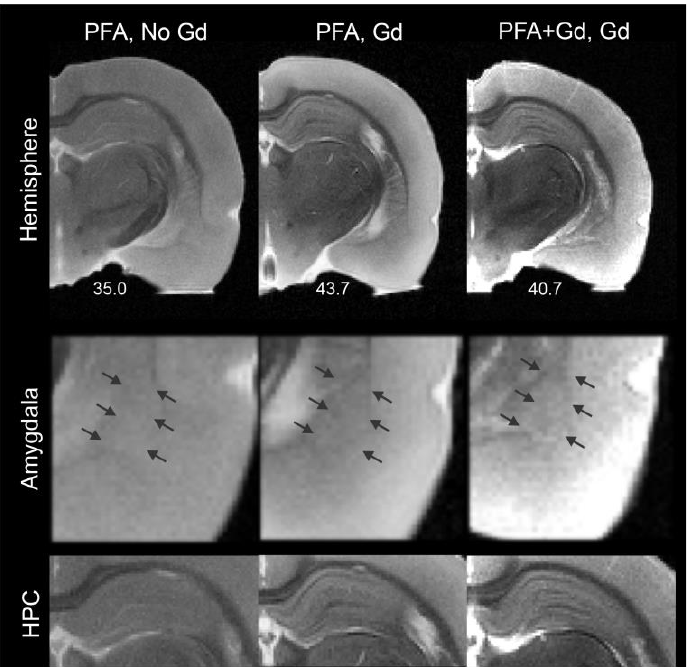
Figure 2. Exogenous contrast does not improve amygdala visualization. Exogenous contrast en- hancement with gadolinium (Gd), either within the perfusate or by immersion of ex vivo brain tissues did not dramatically improve visualization of the amygdala or the BLA (middle panel, arrows indicate the approximate location of the BLA). In contrast and similar to other published reports, the hippocampus (HPC) exhibited enhanced contrast under both treatment paradigms (bottom panel). The SNR values were improved with Gd treatment (values are reported under the hemi- spheres).